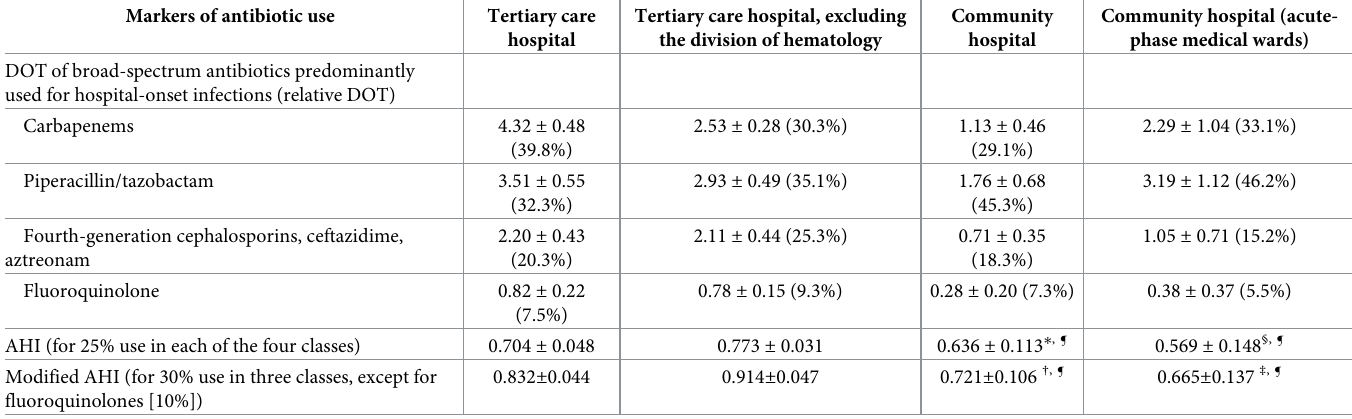
TCH (5.12 ± 0.62) than those in the CH (6.27 ± 1.21, p = 0.008) and acute-phase medical wards in the CH (11.74 ± 2.50, p < 0.001). The DOT throughout the 1-year study period for each category of intravenous antimicrobial agent is presented in S3 Table. The DOT of each broad-spectrum antibiotic predominantly used for hospital-onset infections and the AHIs for this category of antibiotics are presented in Table 2. A significantly higher modi- fied AHI was shown in the TCH than in the CH (0.832 ± 0.044 vs. 0.721 ± 0.106, p = 0.003), indi- cating a more heterogeneous (balanced) use of these antibiotics in the TCH (the target of the AHIs was 1). If the division of hematology was excluded in the TCH, a further increase in the Table 2. Day of therapy (DOT) in each broad-spectrum antibiotic predominantly used for hospital-onset infections, and antibiotic heterogeneity indices (AHIs) for this category antibiotics in the tertiary care hospital and community hospital. Markers of antibiotic